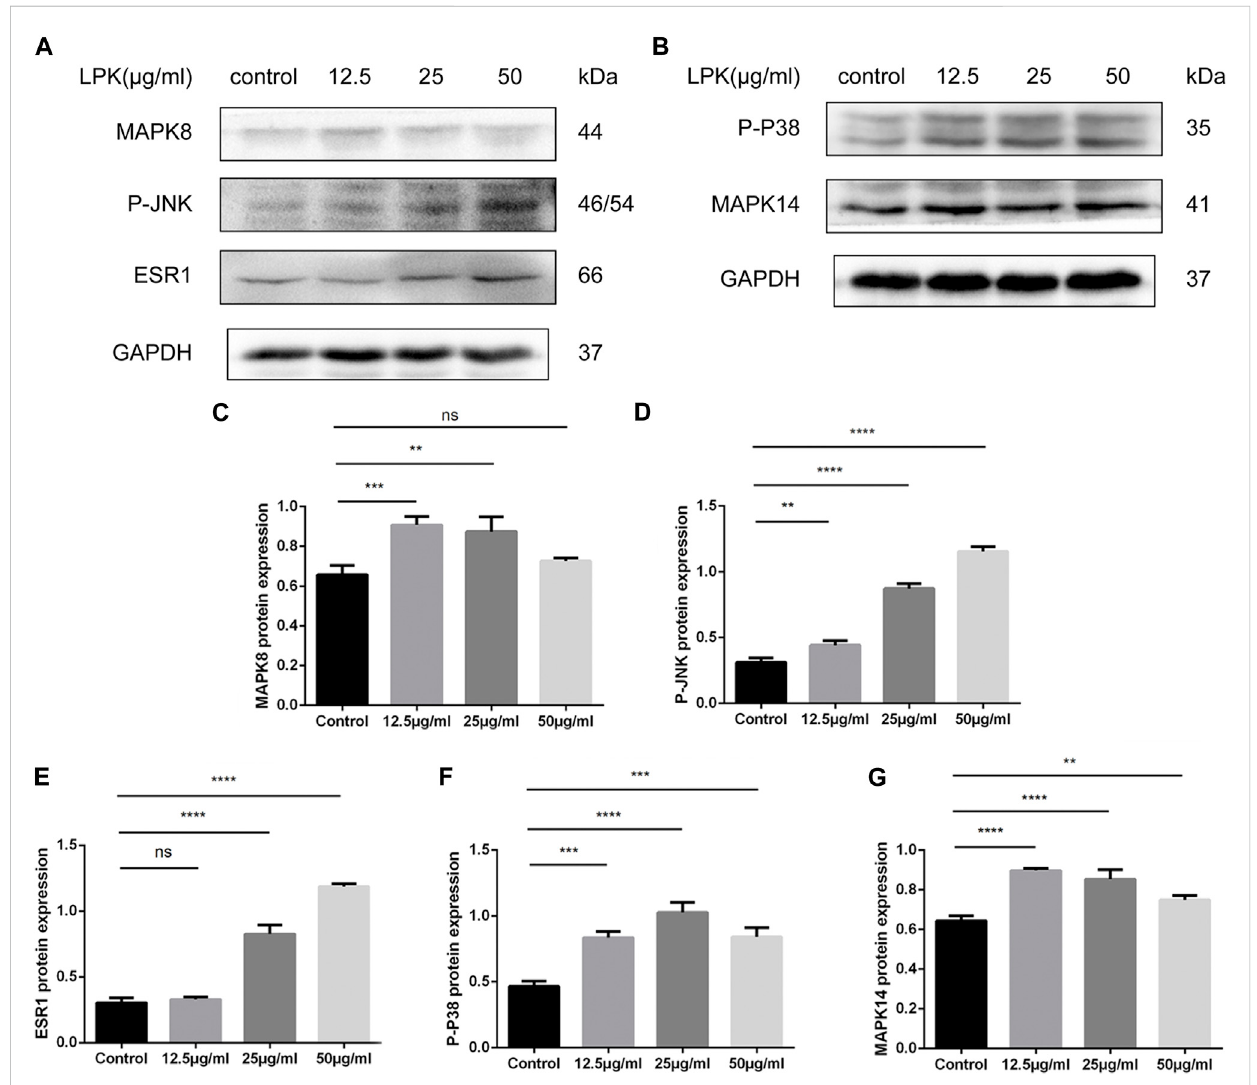
FIGURE 7 Western blot results of LPK-related pathway proteins inosteogenic-induced C3H10cells. (A, B) The expression levelsof estrogen receptor α (ESR1), mitogen-activated protein kinase family members (MAPK8, MAPK14), and their phosphorylated forms (P-P38, P-JNK). (C – G) Comparative analysis of greyvaluesforrelevantproteinbands,dataareshownasmean±SD( n =3).Comparedtothecontrolgroup,differenceswereconsideredsigni fi cantat p < 0.05 (*); p < 0.005 (**); p < 0.0005 (***); p < 0.00005 (****); ns: the difference was not statistically signi fi